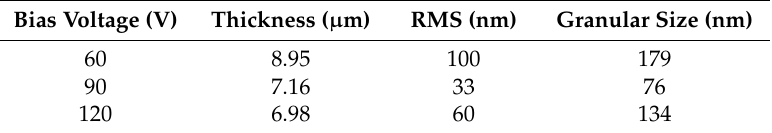
Table 2. Effect of the bias voltage on the morphological properties of the films. Bias Voltage